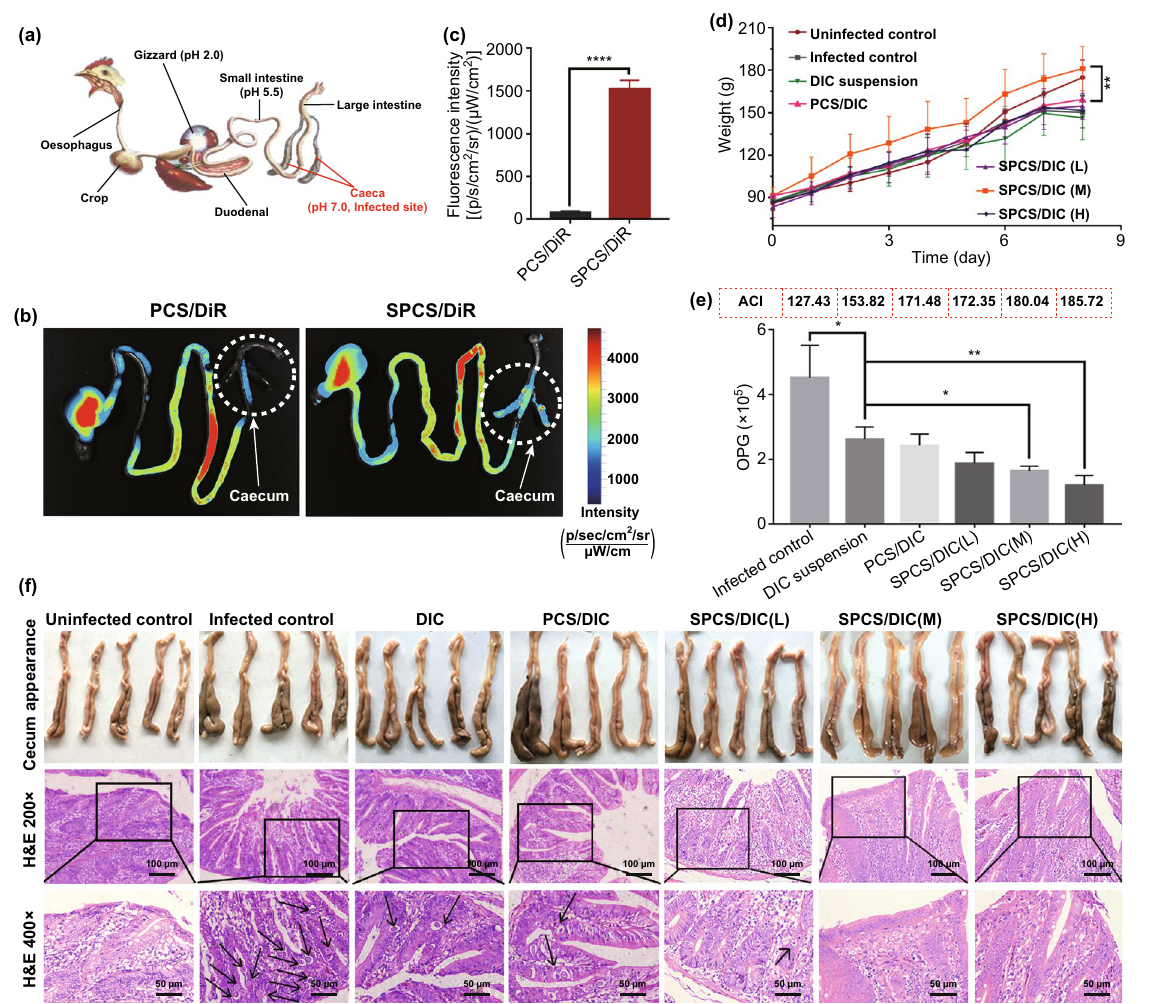
Figure 8 In vivo biodistribution and anti-coccidial efficacy. a Schematic diagram of chicken digestive system and corresponding microenvi- ronments at different sections. b Representative ex vivo images of intestinal tract at 4 h after oral administration of PCS/DiR and SPCS/DiR micelles, respectively. c Quantification of fluorescence intensity in cecum. d Average weight change of the chicks administrated by DIC suspen- sion, PCS/DIC and SPCS/DIC (L, M, H) micelles, with the infected and uninfected groups as controls. e Number of oocysts per gram of feces (OPG) and ACI values representing anti-coccidial capacity of different DIC formulations. f Cecum appearance and H&E staining images were collected after the experiments. Data are expressed as mean ± SD, n = 10. * p < 0.05, ** p < 0.01 and **** p <